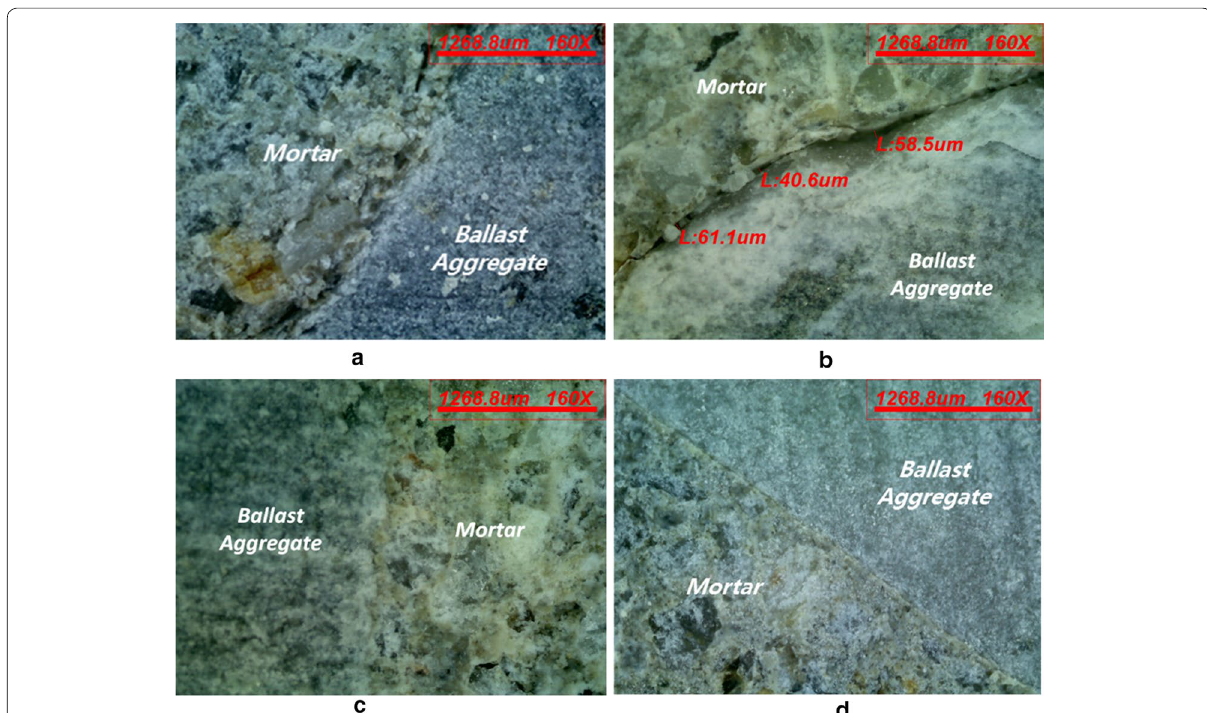
Fig. 23 Damaged ITZs with H-level aggregates after freeze–thaw testing: a C-H-0, b C-H-2, c C-H-6, and d C-H-10 [magnification factor: 160].